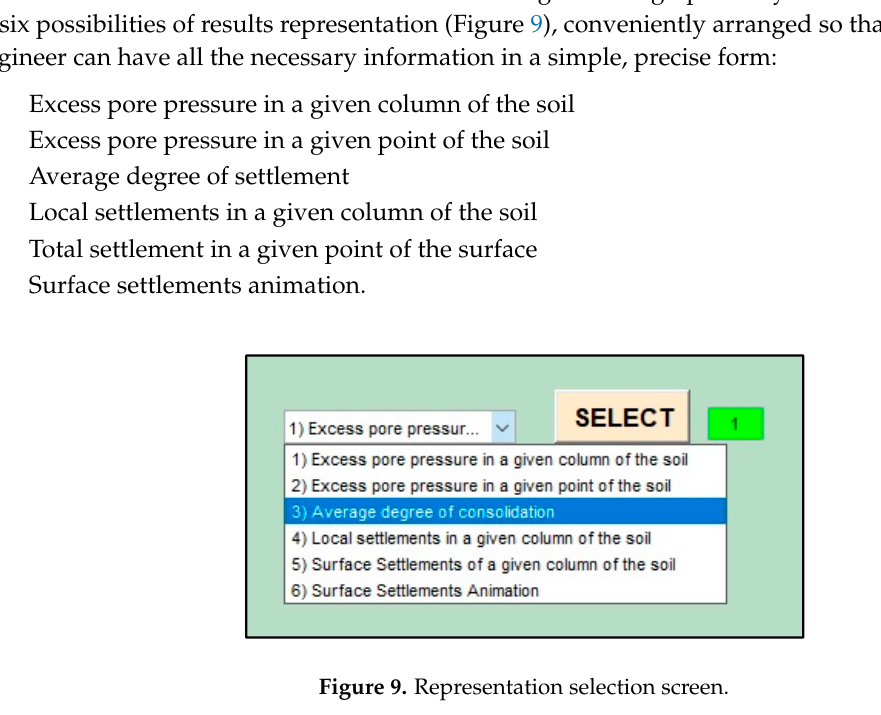
Table 1. Geometry of the problem and soil properties.